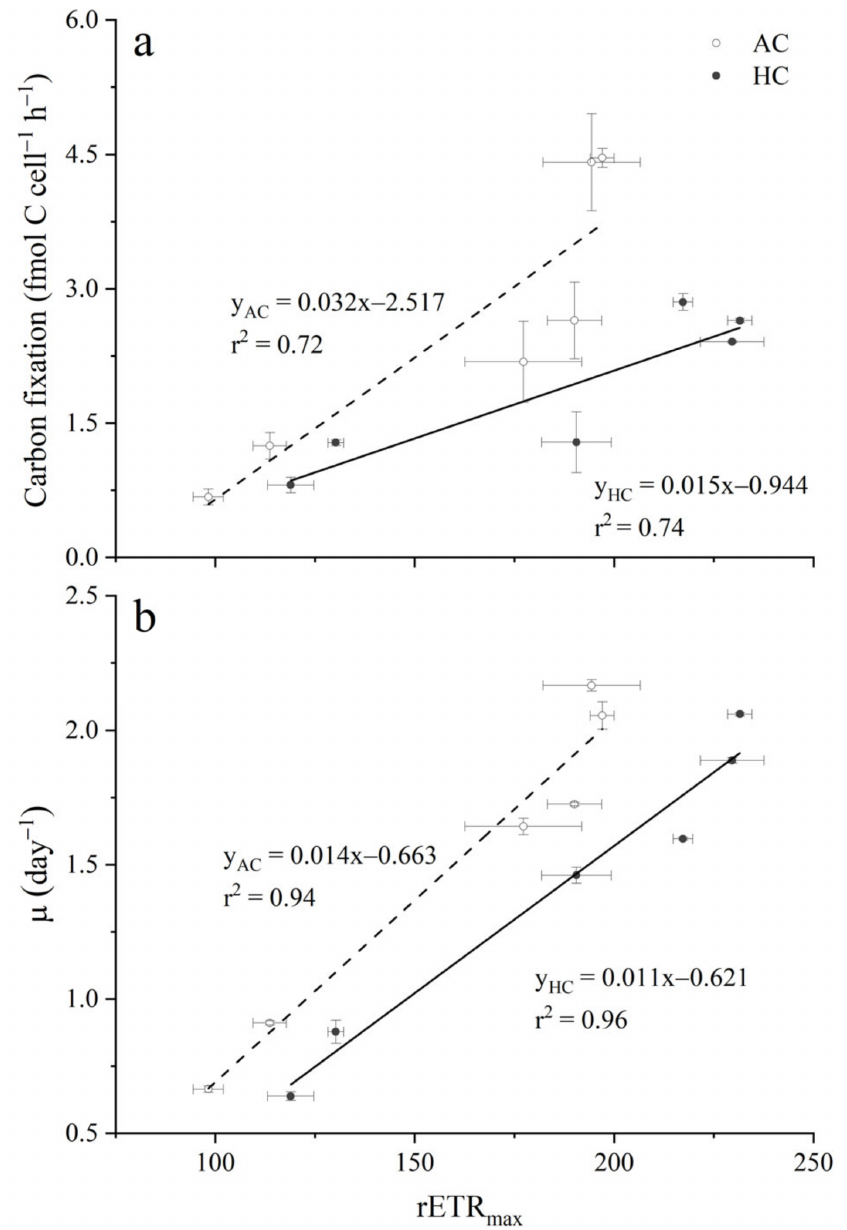
Figure 4. Plots of carbon fixation rate ( a ) and growth rate ( b ) versus rETR max of Synechococcus CB0101 grown under different light levels combined with the ambient (AC, 415 µ atm, the dotted line) or elevated (HC, 1000 µ atm, the solid line) p CO 2 . The values are means ± SD of triplicate cultures. There were close correlations between carbon fixation or growth rate and rETR max